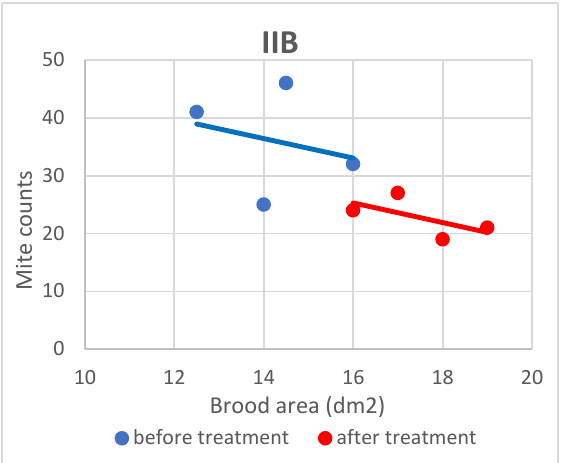
Figure 6. Linear regression plots of brood area (fixed factor) and mite counts in subgroup IIB before and after treatment.